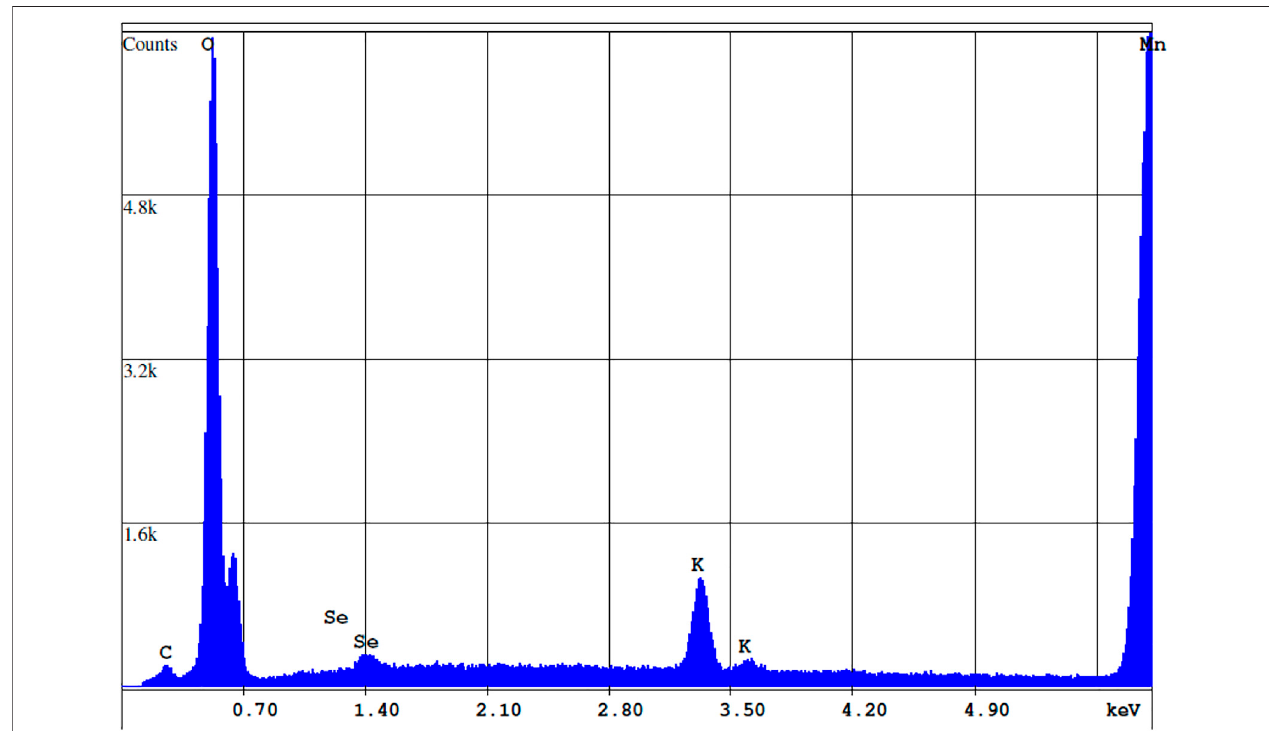
FIGURE9| EDSspectrumoftheprecipitatecross-sectionhighlightedin Figure8 .ConcentrationsofMn,Se,O,andKare66.22,1.2,29.38,and3.21%byweight respectively.